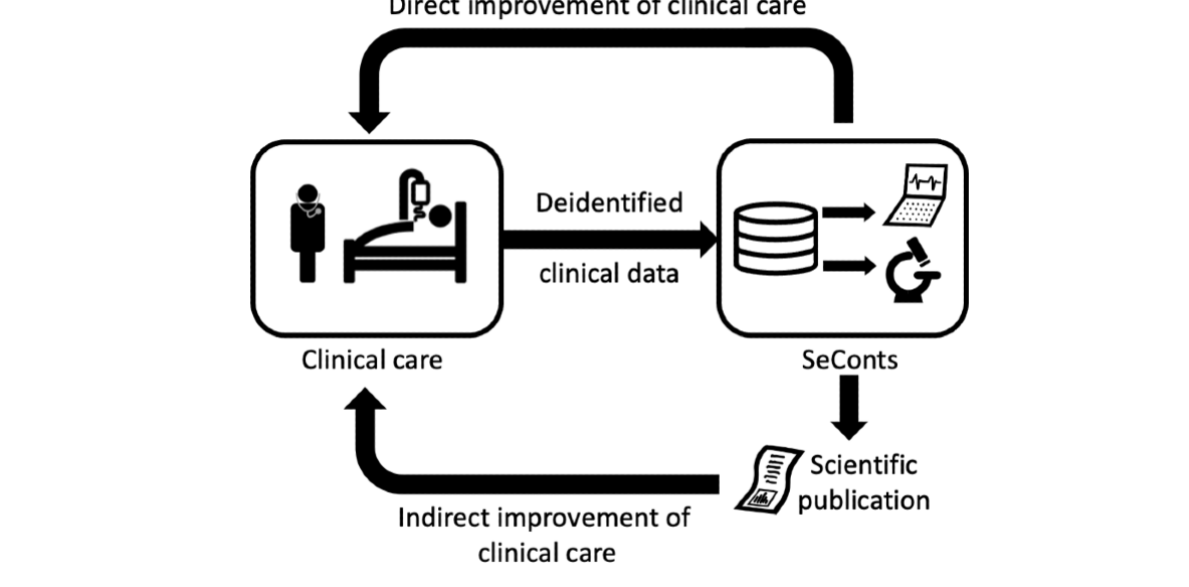
Regarding the operationalization of probability , we assume that the most negative consequences for the individual patient are only expected if the patient can be identified from the